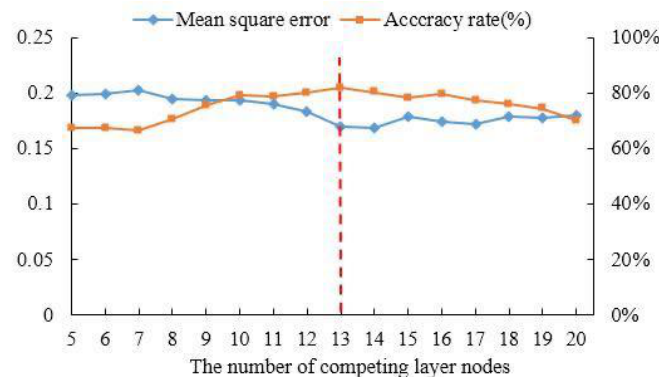
Figure 14. The accuracy rate and MSE of different numbers of neurons